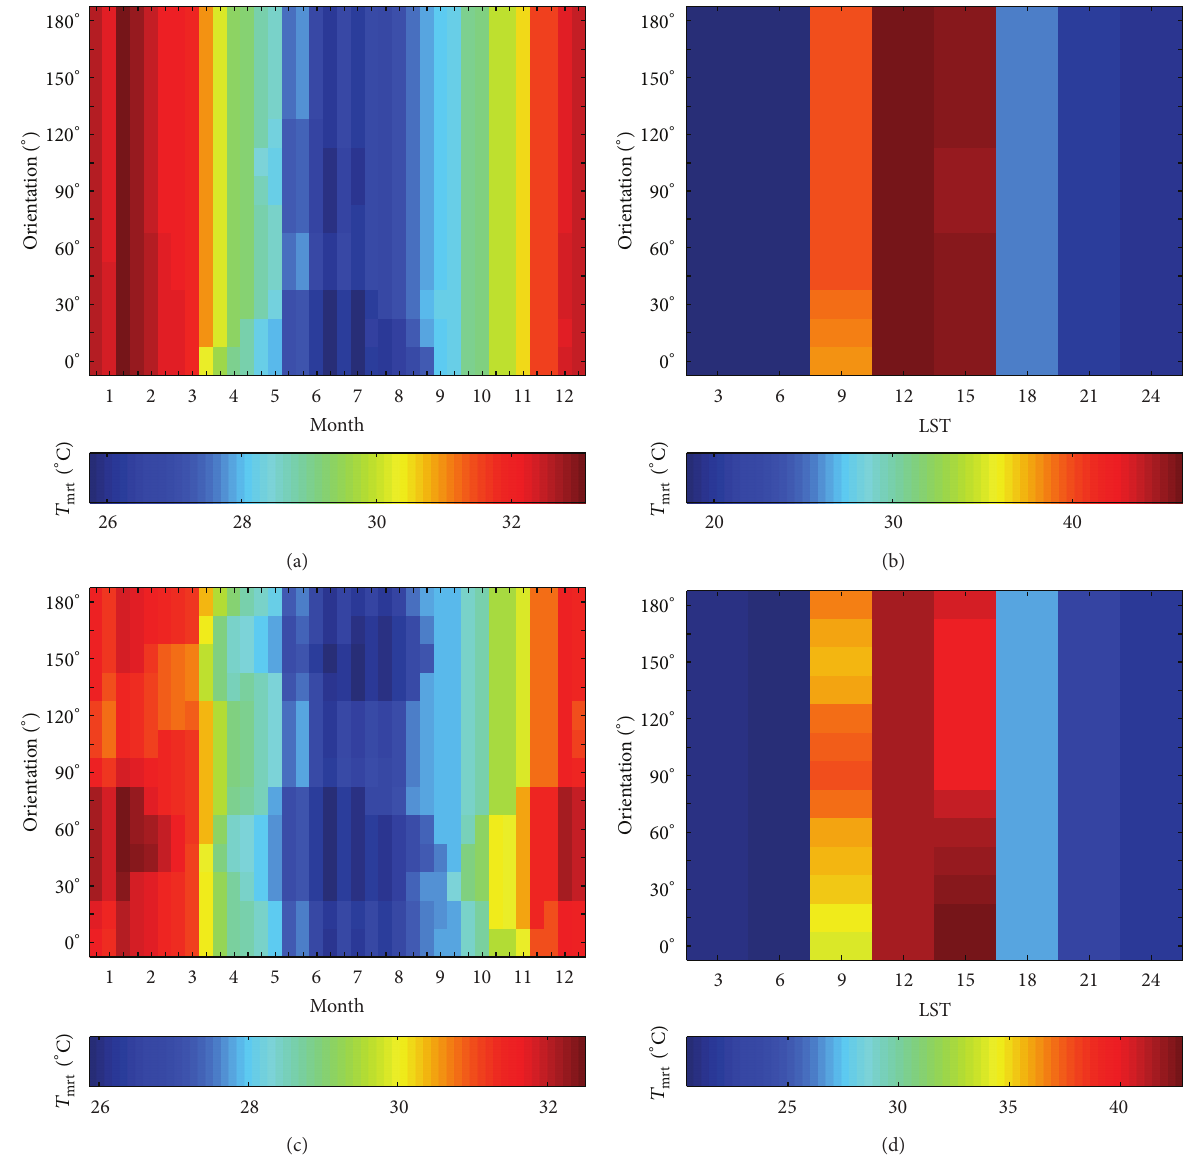
Figure 7: Effects of orientation on the temporal distribution of 𝑇 at the urban street when the buildings’ height was kept at 5 m, depicted mrt (a) and the diurnal cycle (b). ((c) and (d)) show the corresponding effects when the buildings’ height was in terms of the annual cycle of 𝑇 mrt kept at 25 m